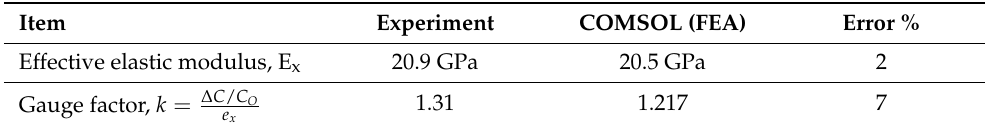
Table 8. Finite element stress predictions for the unit cell for 1961 ( µ ε ) and 3305 ( µ ε ).